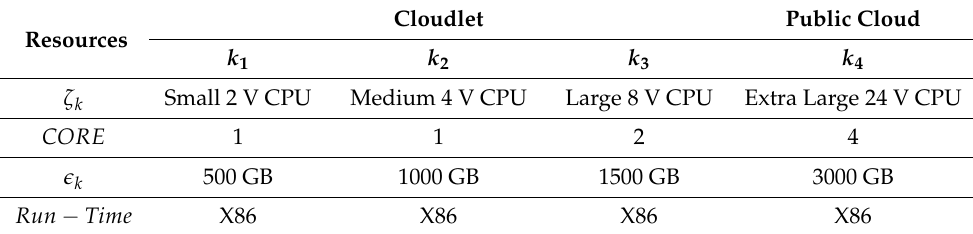
Table 4. Mobile Cloudlet Based Cloud Network.